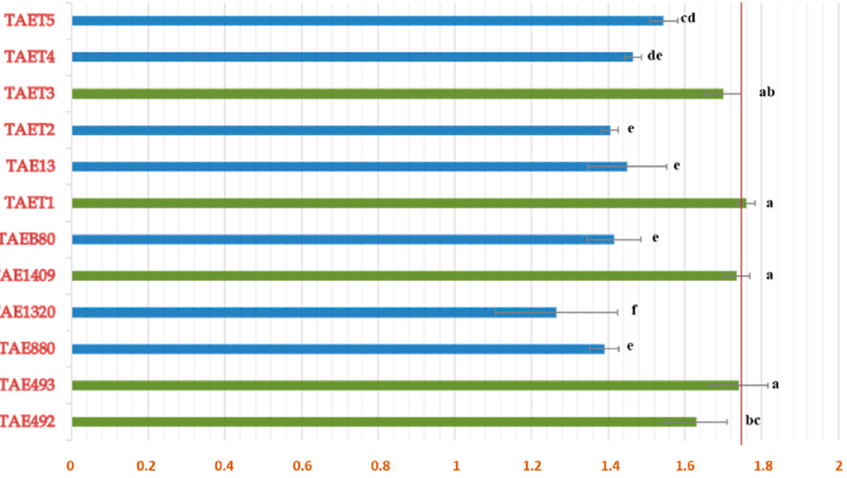
Figure 2. Growth rate (cm d − 1 ) of different T. aggressivum f. europaeum isolates. Different letters indicate significant differences according to the one-way ANOVA ( p = 0.05). (Accession number TAET1: MW751677.1).